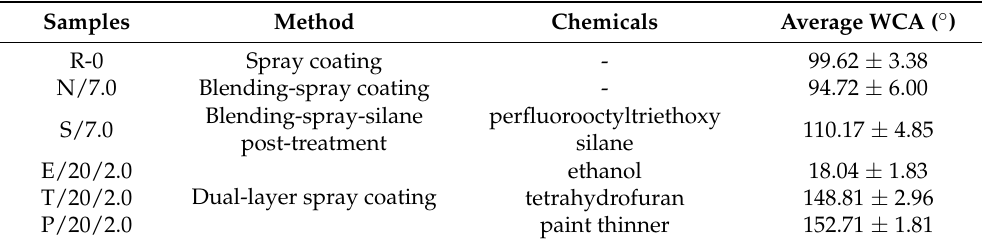
Table 3. Average WCA of PU coating prepared using different methods.